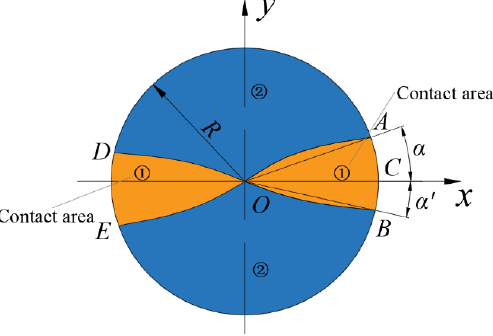
Figure 2. Contact area between the cone roll and the workpiece.